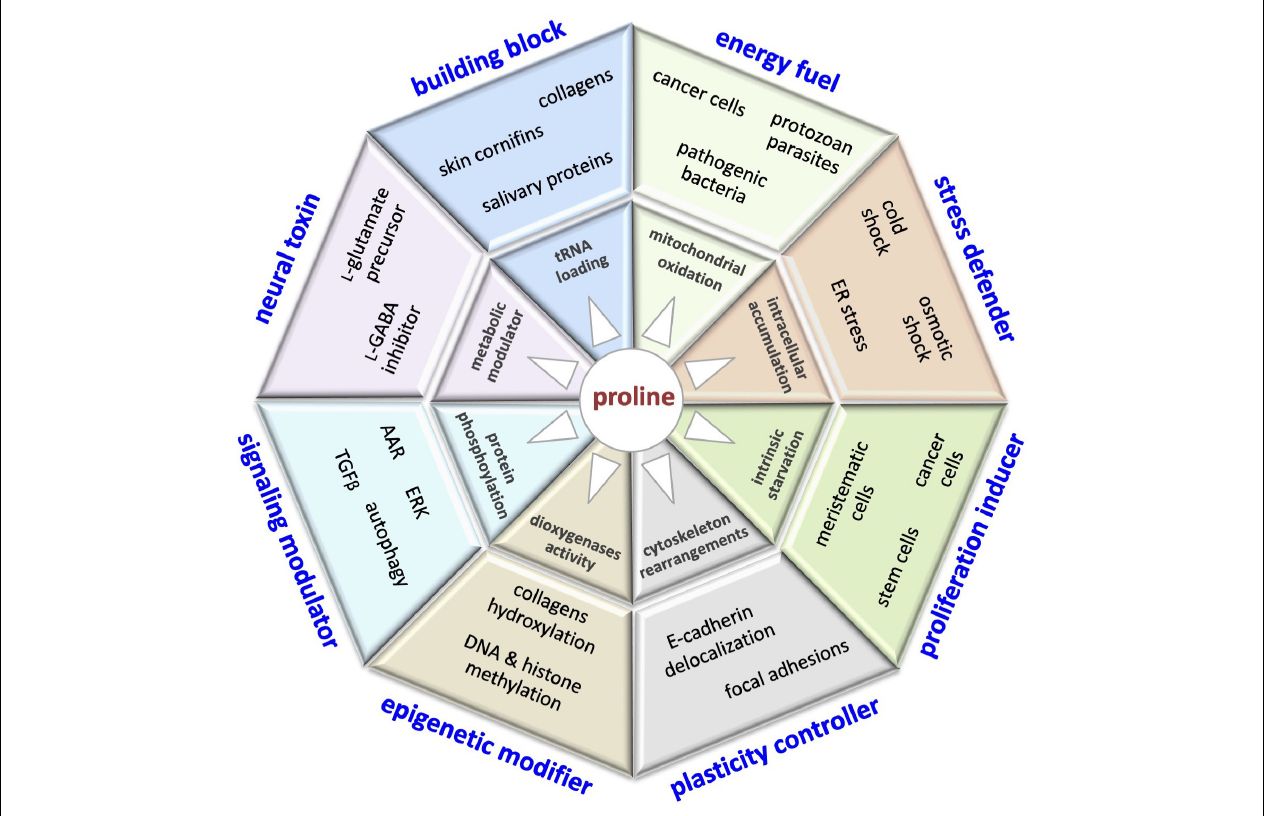
FIGURE 10 | This illustration encompasses the multifaceted roles of proline in cell biology, including: building block of proteins (collagens, cornifins, salivary proteins); energy fuel (bacteria, parasites, cancer cells); stress defender (cold shock, drought/salinity, ER stress); proliferation inducer (stem, meristematic, cancer cells); plasticity controller (cell shape, motility); epigenetic modifier (DNA/histone methylation); modulator of cell signaling pathways (AAR, autophagy, ERK, TGF β ) and neural toxin associated